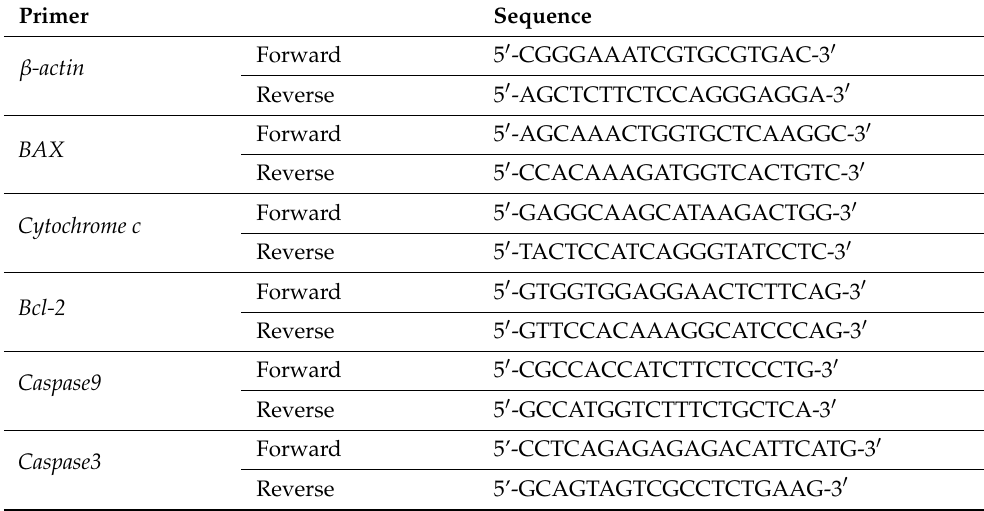
Table 1. Apoptotic primer